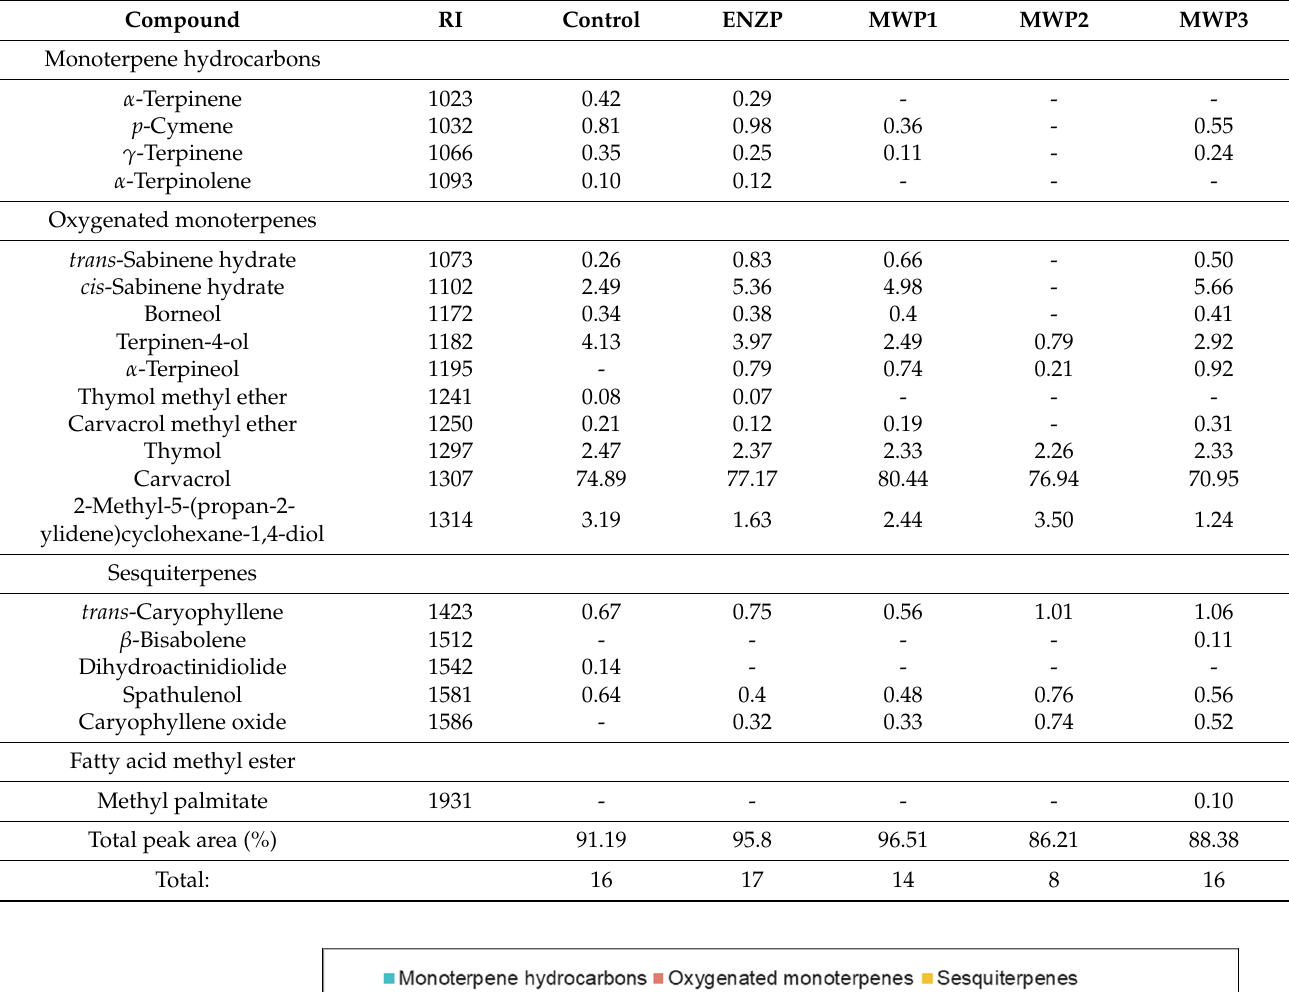
Table 1. GC/MS analysis of oregano extracts obtained by supercritical carbon dioxide extraction (pressure 200 bar, temperature 40 ◦ C, extraction time 4 h).